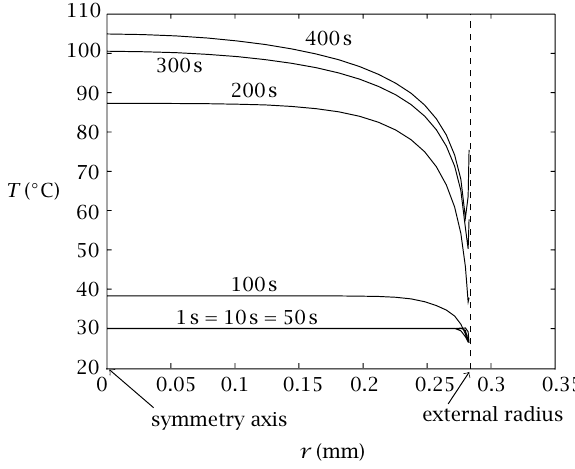
Figure 5.6 . Radial temperature profile at z =